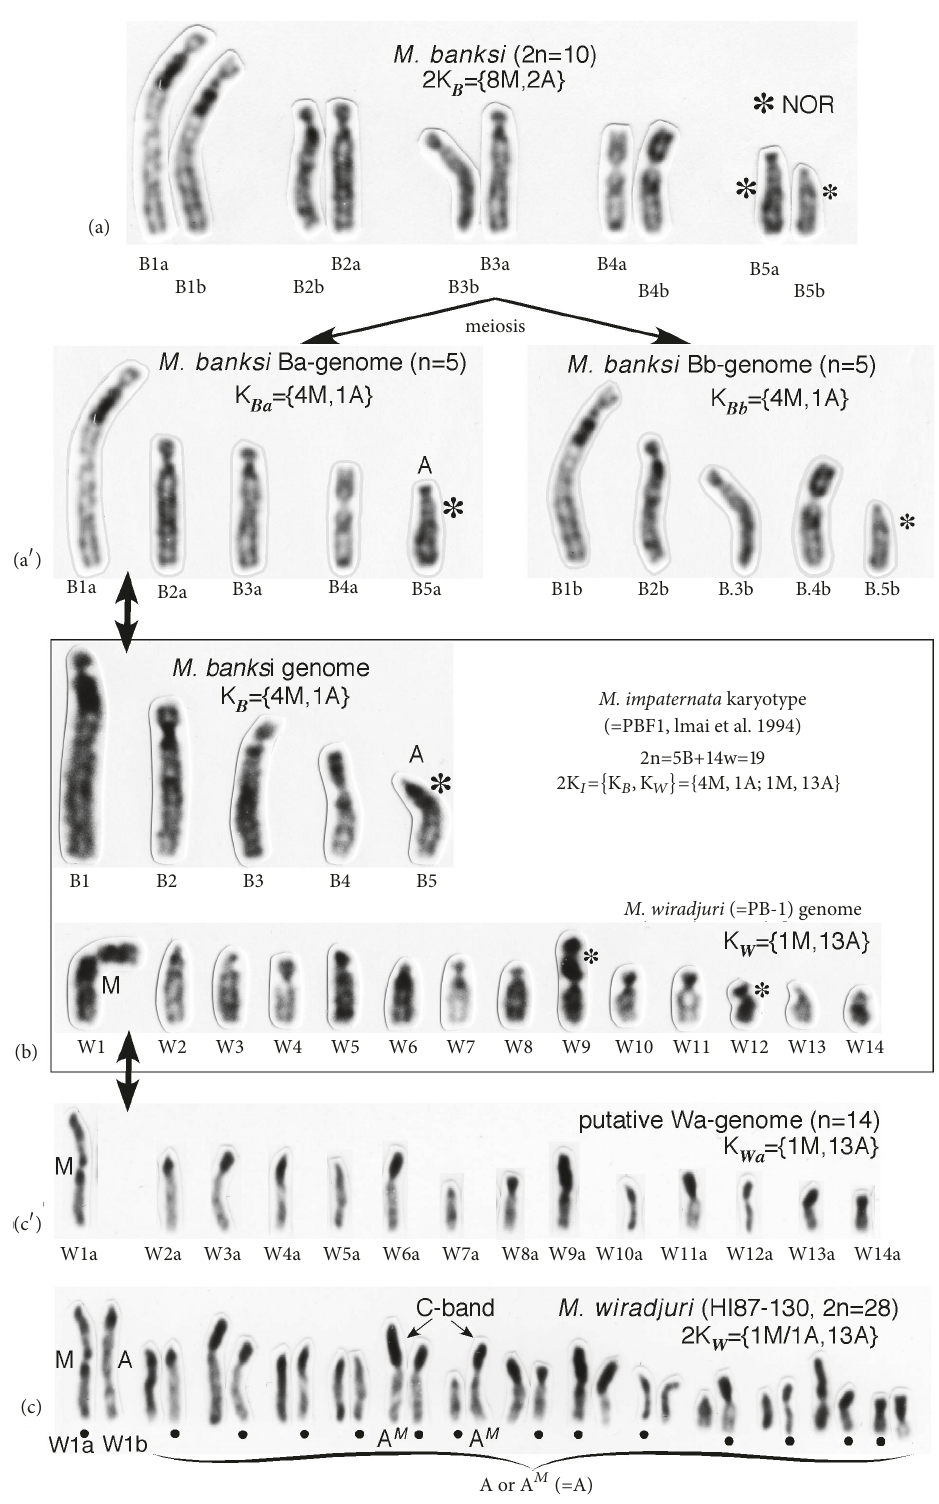
Figure 2: Comparison of karyotypes of Myrmecia banksi (a, a 󸀠 ), M. impaternata (b), and M. pilosula (c, c 󸀠 )(HTI) . A = acrocentric, M = metacentric, and NOR = Nuclear Organiser